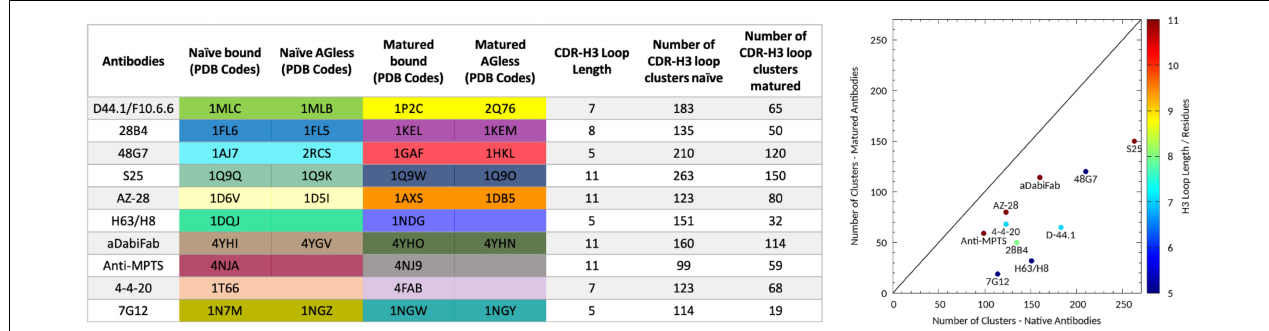
FIGURE 1 | Overview of all antibody fragments analyzed with the available PDB accession codes crystallized with and without antigen and in the naive and matured state. Additionally, the resulting number of clusters of the CDR-H3 loop of the naïve and matured antibody fragments by using the same distance cut-off of 1.2 Å is shown on the left and visualized on the right. The plot on the right shows the number of clusters of the naïve antibody against the number of clusters of the matured antibody color-coded according to their loop